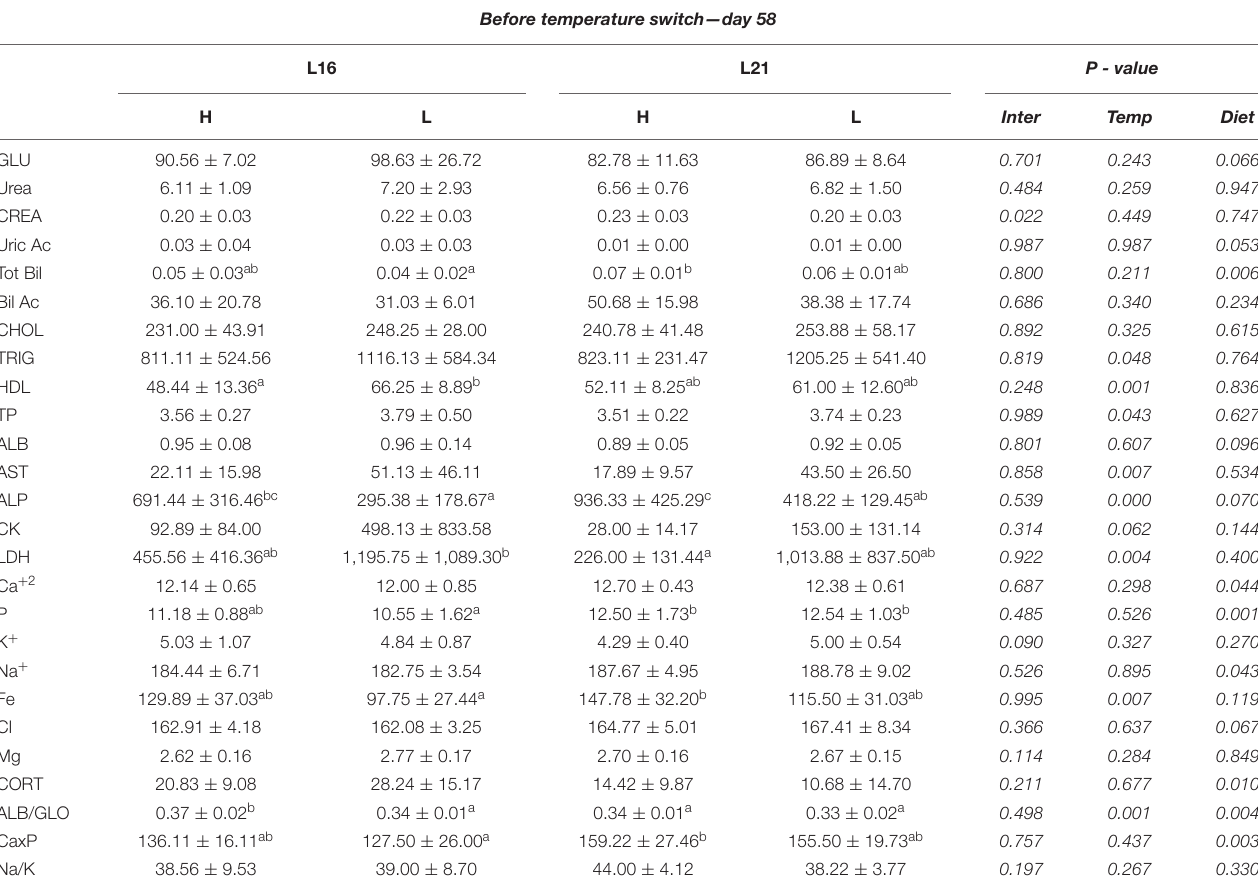
TABLE 4 | Plasma biochemistry values for gilthead sea bream fed the experimental diets and exposed to two different temperatures before temperature switch. Before temperature switch—day